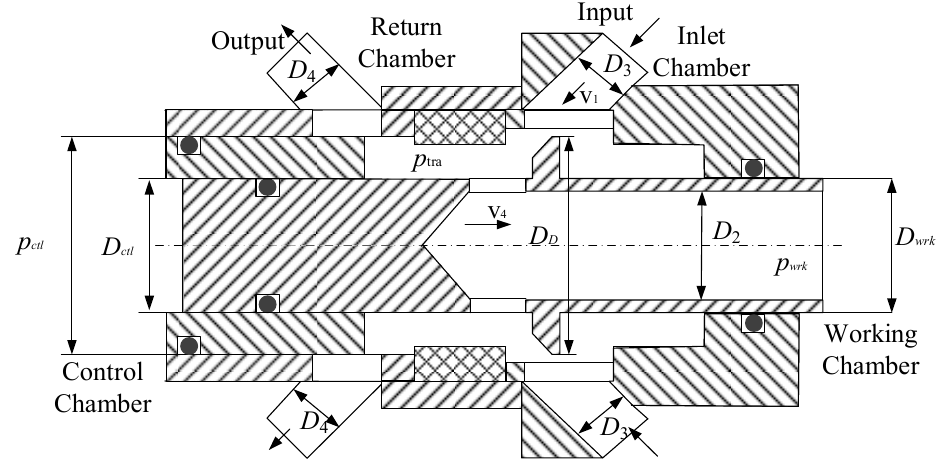
Figure 7. Structural diagram of the ordinary directional valve. Generally, the opening of the valve spool is relatively small and limited. As long as the hydraulic pressure of the control chamber is greater than those of the inlet chamber,